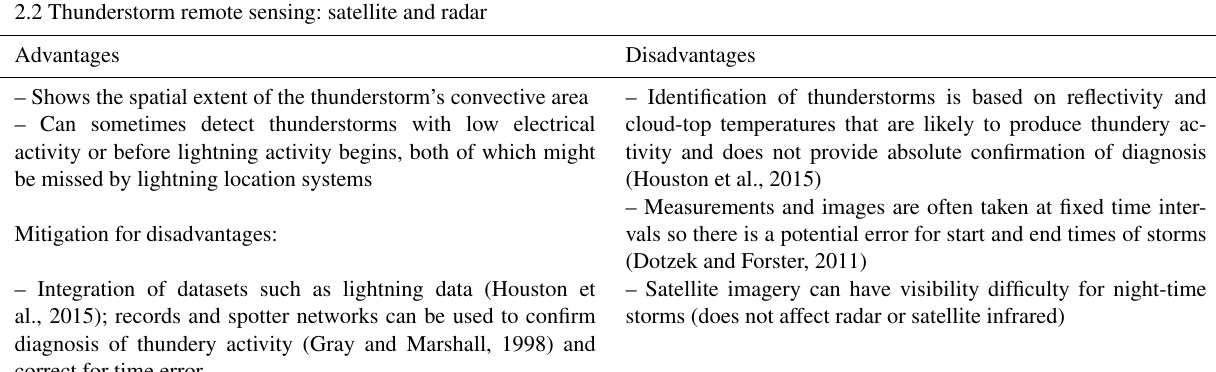
Table 2. Strengths and weaknesses of thunderstorm remote sensing (satellite and radar) used to produce thunderstorm and lightning clima- tologies.